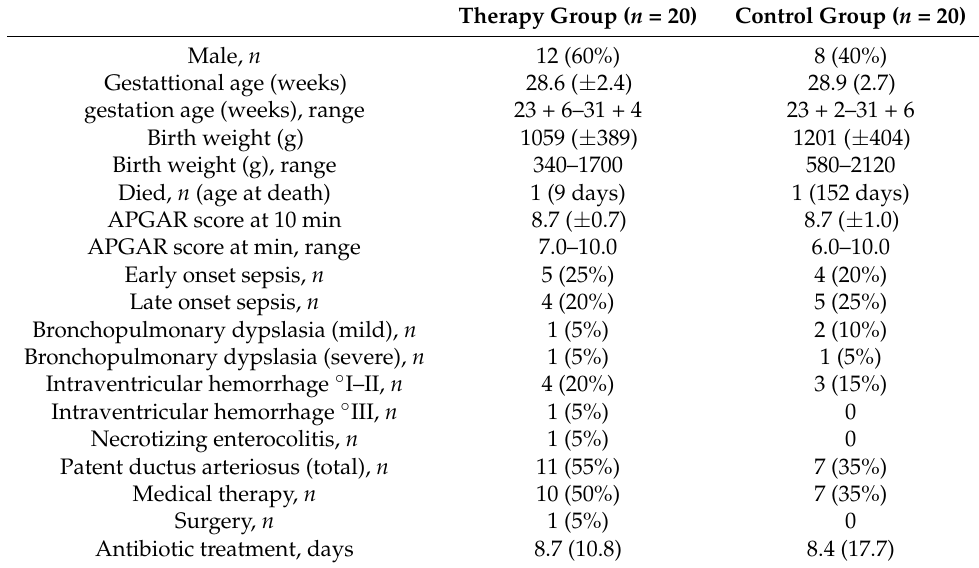
Table 1. Clinical characteristics of the included patients in the therapy and the control